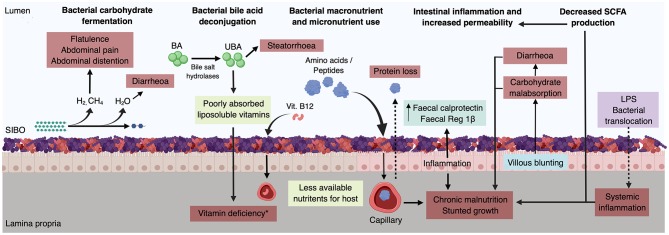
Mechanisms through which SIBO affects the host. The dotted arrows indicate increased intestinal permeability. * Includes vitamin A, D, E, and vitamin B 12. Vitamin K is synthesised by the gut microbiota, and thus its deficiency in this context is very unlikely. BA, bile acids; UBA, unconjugated bile acids; LPS, liposaccharides. Created with BioRender.com.